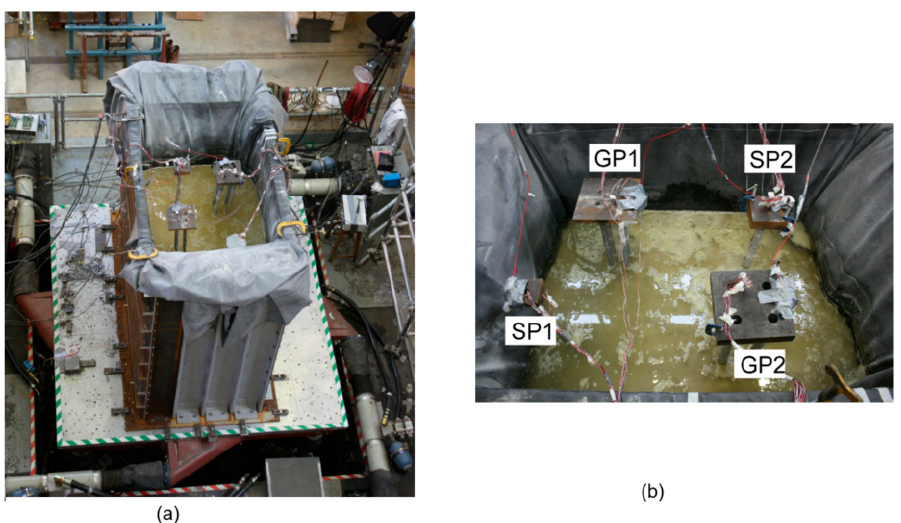
Figure 31. Shaking table tests on small-scale models of monopile- and pile-supported structures for the jacket: ( a ) geotechnical model container and shaking table; ( b ) model tests representing monopile-supported structures (SP1 and SP2) and 2 × 2 pile-supported